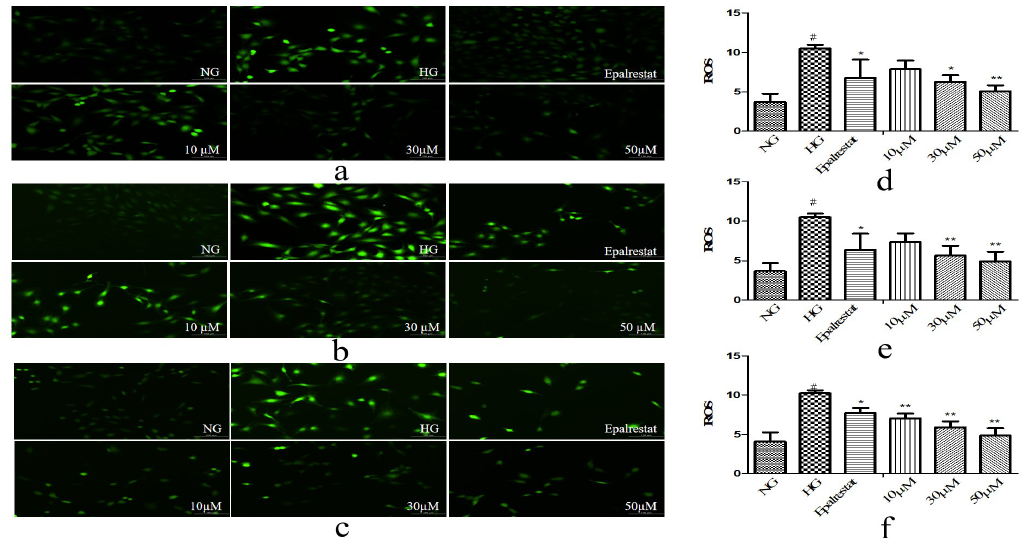
Figure 6. Compounds 2 (a,d) , 6 (b,e) , and 7 (c,f) inhibited the marker of oxidative stress reactive oxygen species (ROS) induced by high glucose in GMCs. GMCs were incubated with or without compounds 2 , 6 , and 7 (10, 30, and 50 μM) under the 5.6 mM glucose (normal group, NG) or 25 mM high glucose (high-glucose group, HG) for 48 h. ＃ p < 0.01 relative to the NG, and ** p < 0.01, * p < 0.05 relative to the HG.